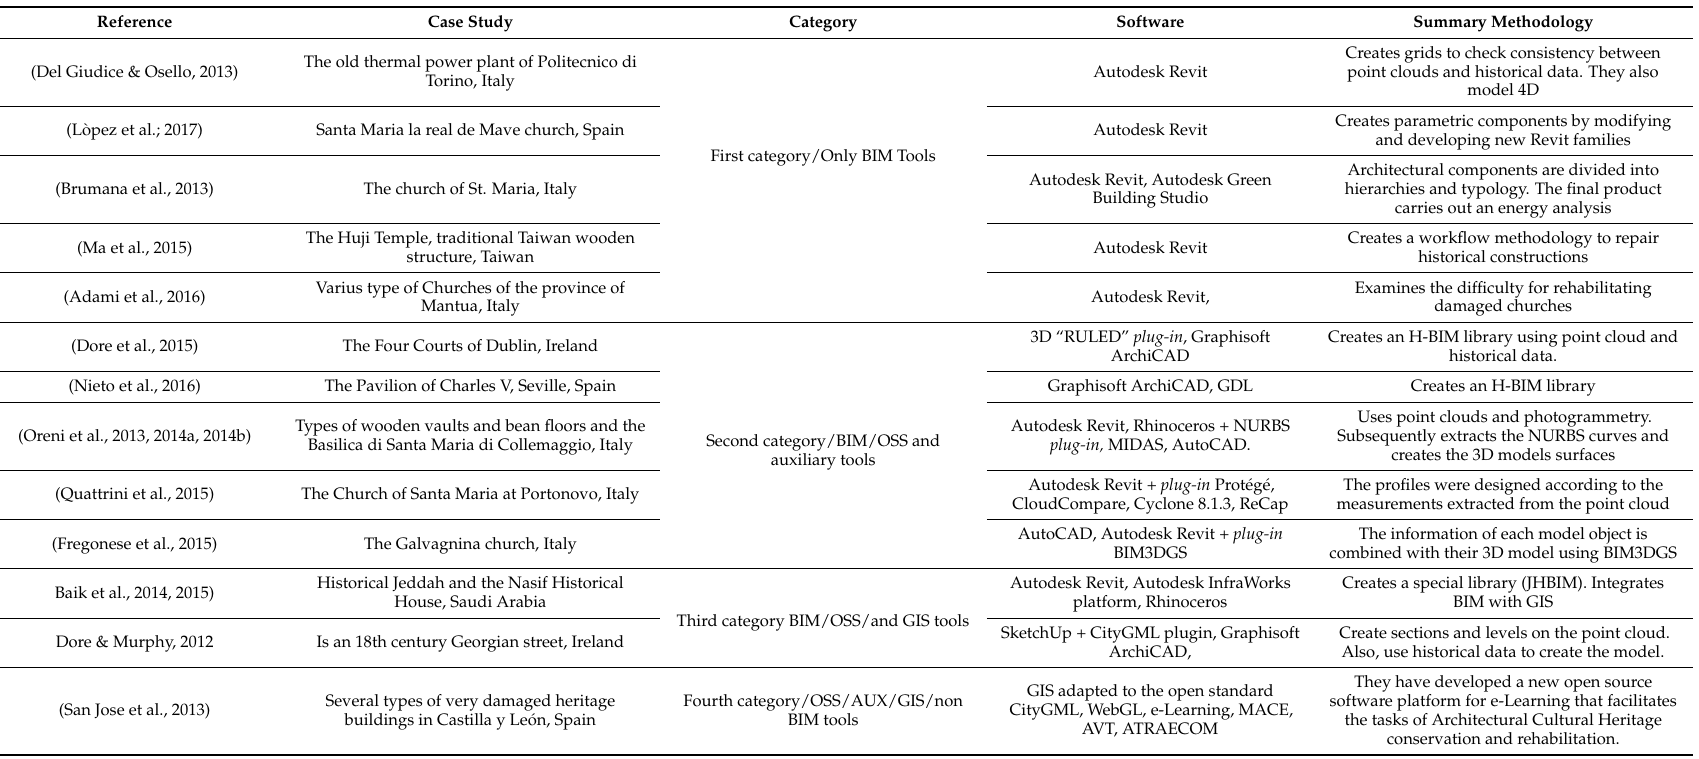
Table 3. Current approaches and tools used in the modeling of historic